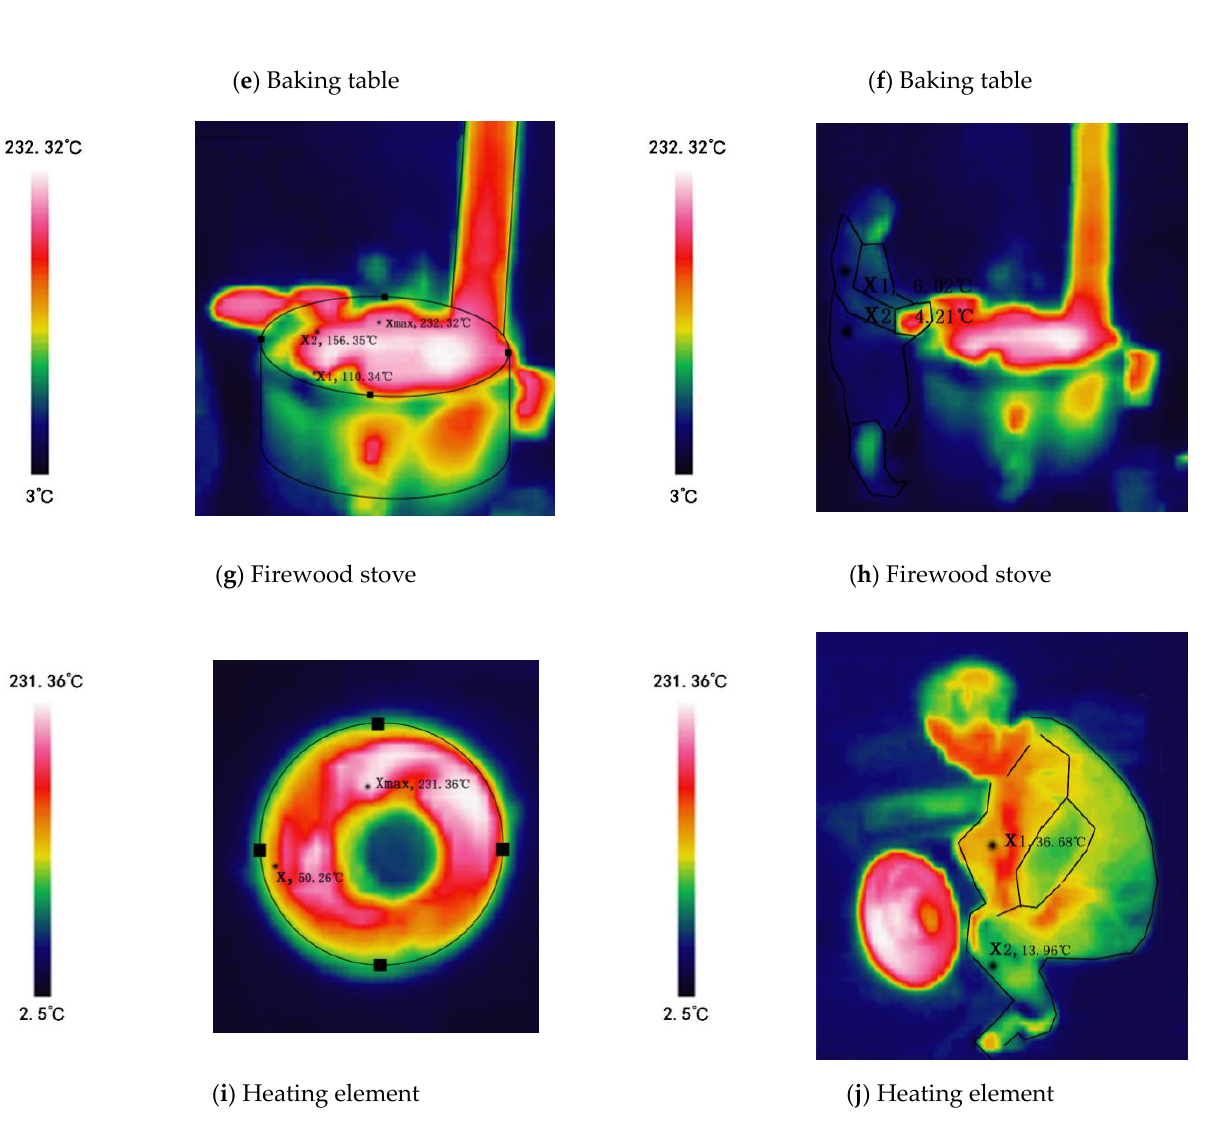
Figure 6. ( a ) Fire pond temperature distribution; ( b ) Fire pond and human body temperature distribution; ( c ) Charcoal brazier tem- perature distribution; ( d ) Charcoal brazier and human body temperature distribution; ( e ) Baking table temperature distribution; ( f ) Baking table and human body temperature distribution; ( g ) Firewood stove temperature distribution; ( h ) Firewood stove and hu- man body temperature distribution; ( i ) Heating element temperature distribution; ( j ) Heating element and human body tempera- ture distribution.